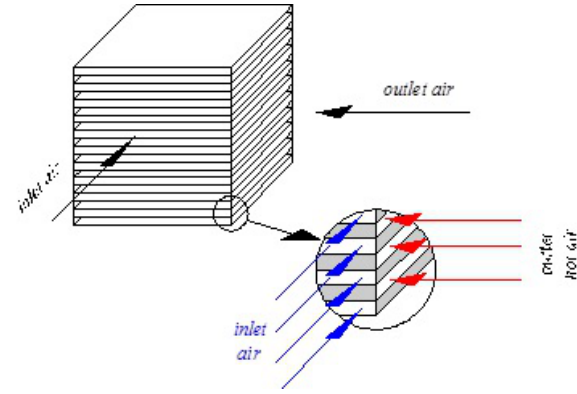
Figure 12: Influence of the outdoor air temperature on the cooling capacity of the refrigeration equipment.